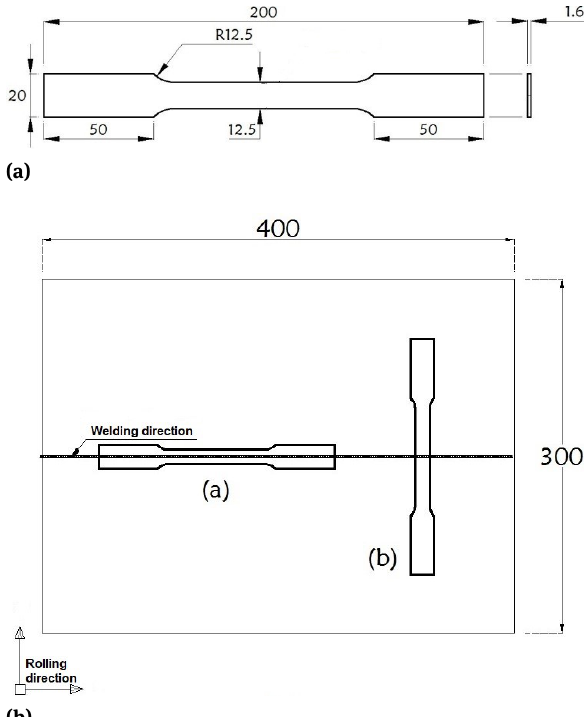
Figure 4: (a) The tensile test specimen geometry; and (b) Configu- ration for longitudinal and transversal direction of the welding and rolling orientation (all units are in